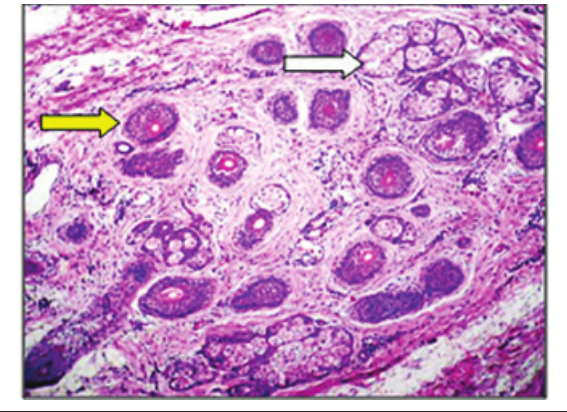
figuRE 4 − Photomicrograph (HE staining, 10× objective lens) Presence of skin annexes: hair follicles (yellow arrow) and sebaceous glands (white arrow). HE: hematoxylin and eosin.